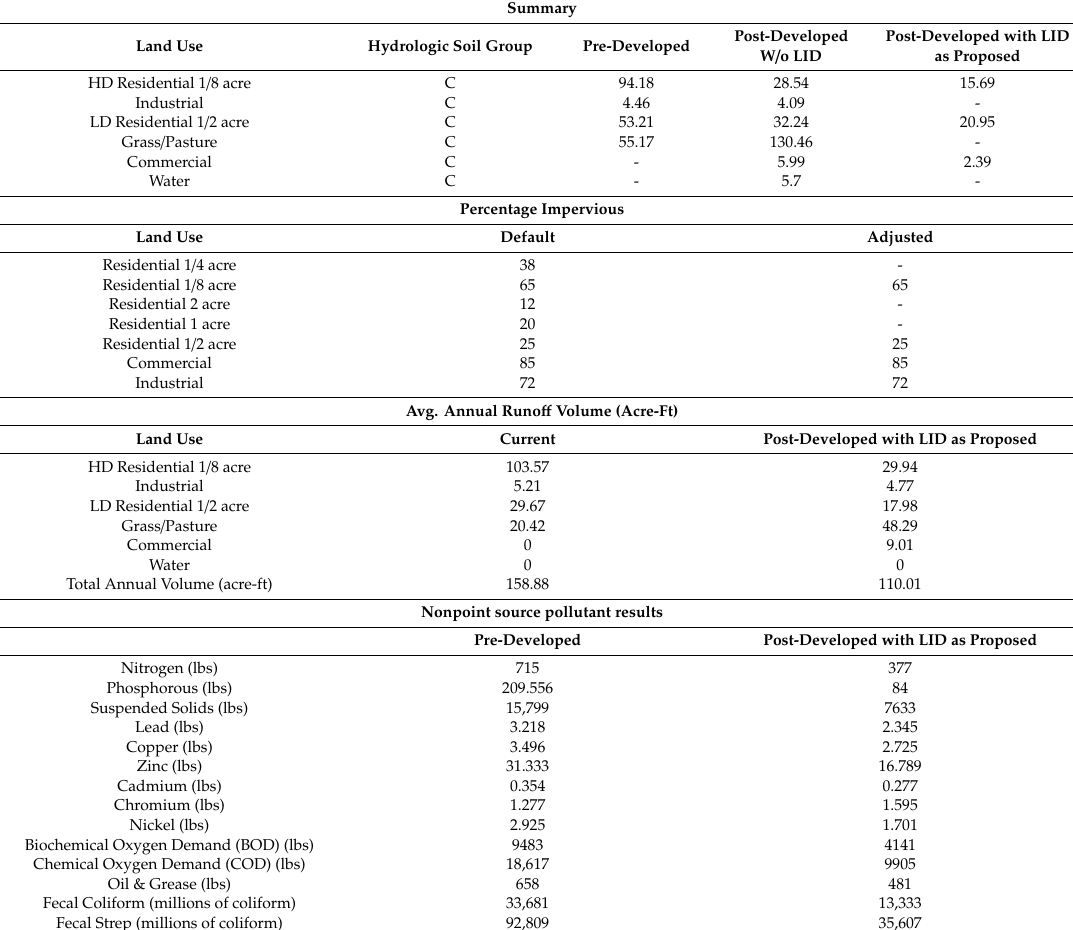
Table 3. Long-Term Hydrologic Impact Assessment (L-THIA) Low Impact Development (LID) spreadsheet inputs and outputs measuring master plan